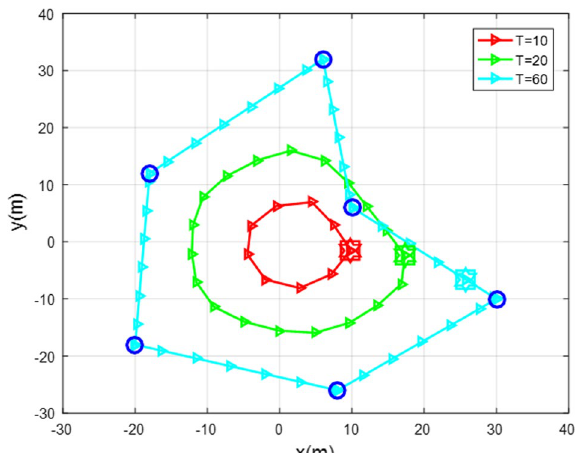
Fig. 2 Optimized trajectories of UAV with different flying times T (circles represent BDs, triangles represent sampling